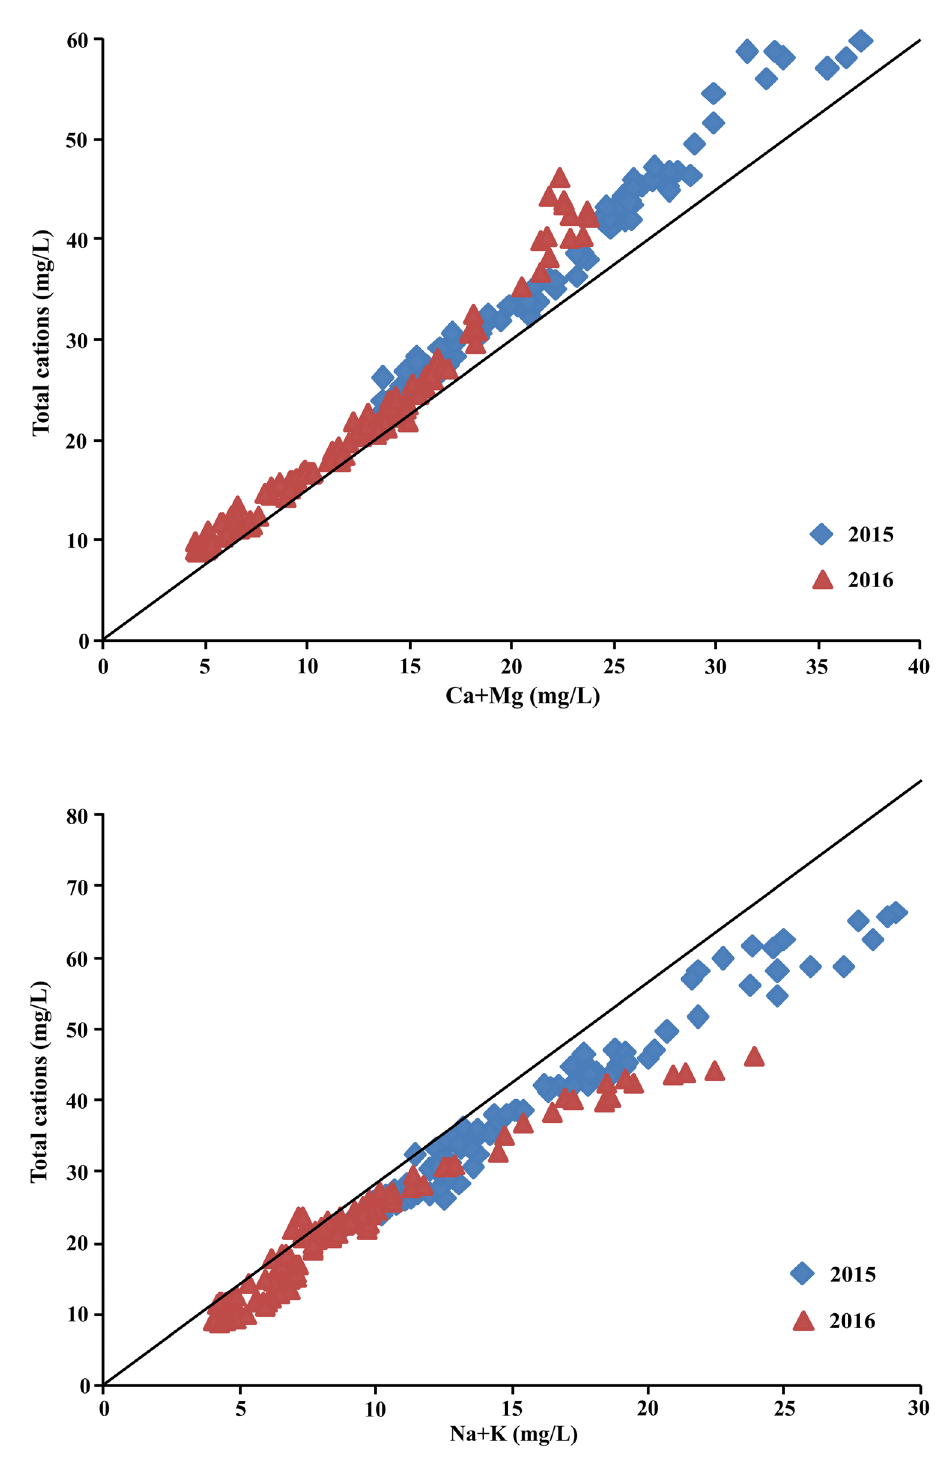
Fig. 5 Scatter plot between total cations and (Ca + Mg) for Chaturangi glacier meltwater